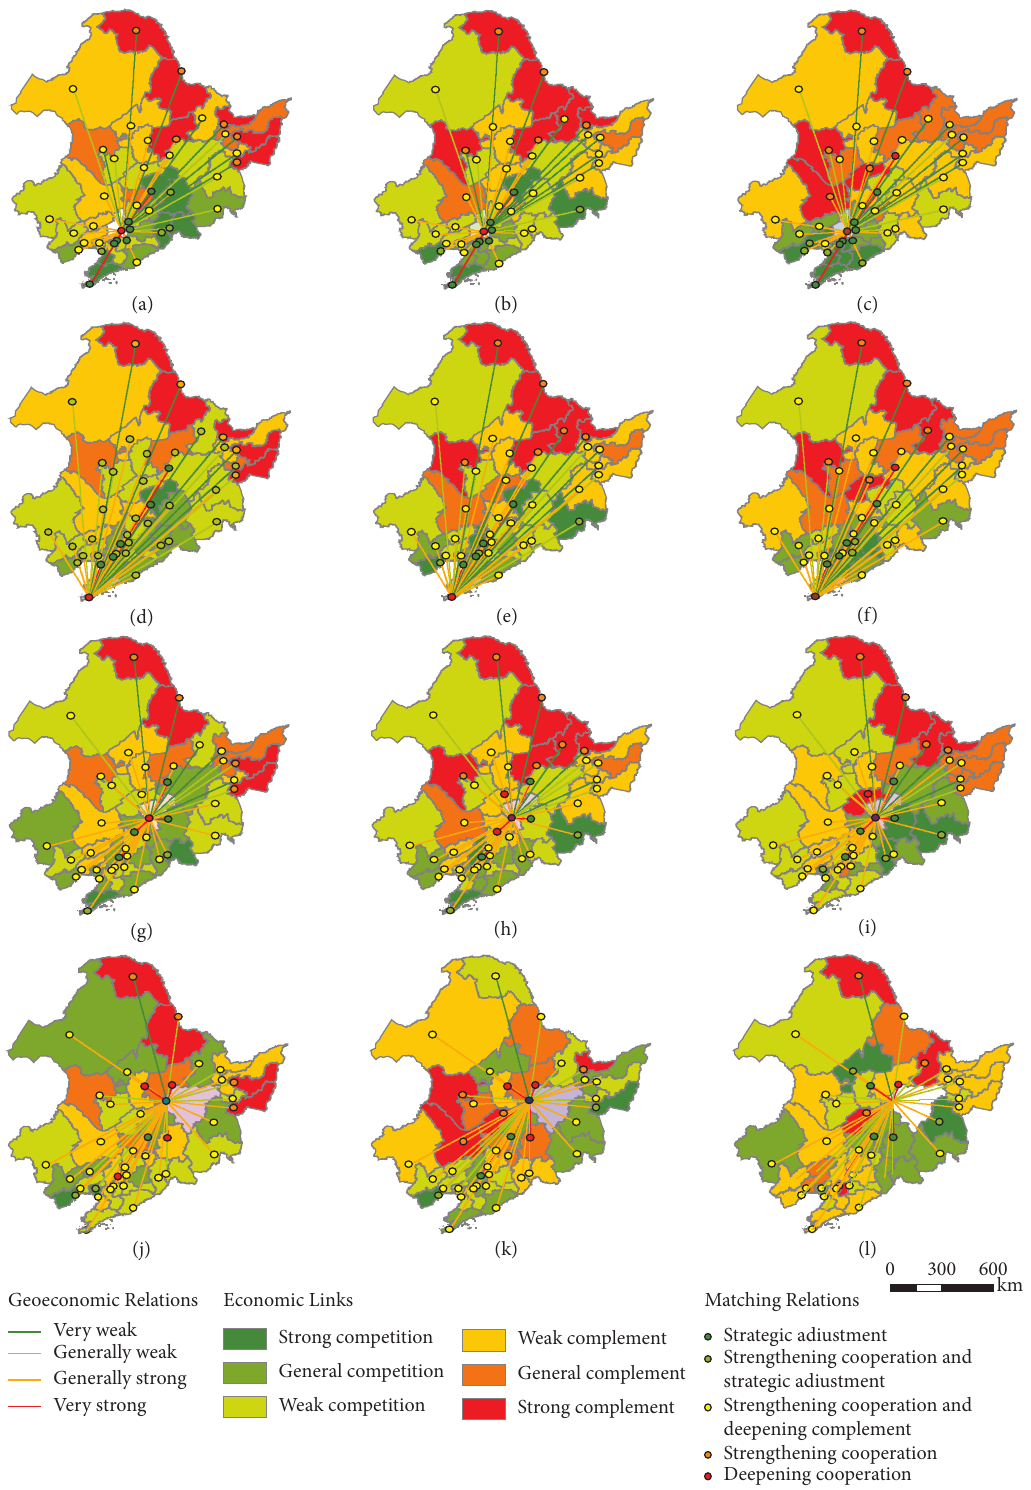
Figure 2: Northeast China’s urban economic relations, geoeconomic relations, and their matching relations in 2007, 2012, and 2017. (a) Shenyang, the period of 2007. (b) Shenyang, the period of 2012. (c) Shenyang, the period of 2017. (d) Dalian, the period of 2007. (e) Dalian, the period of 2012. (f) Dalian, the period of 2017. (g) Changchun, the period of 2007. (h) Changchun, the period of 2012. (i) Changchun, the period of 2017. (j) Harbin, the period of 2007. (k) Harbin, the period of 2012. (l) Harbin, the period of